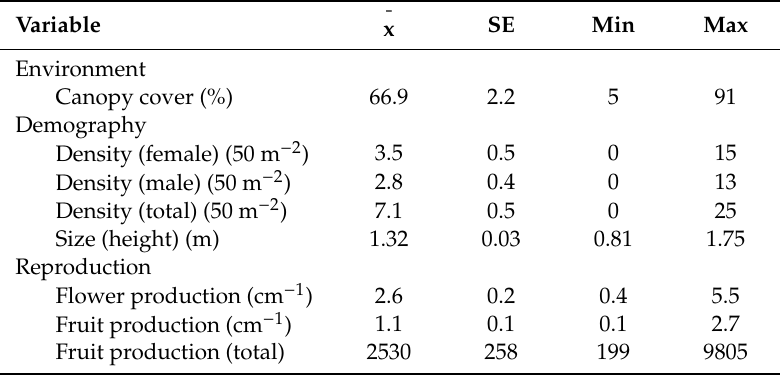
Table 1. Environmental, demographic, and reproductive variables for Shepherdia canadensis individuals in Terwillegar Park (Edmonton, Alberta,